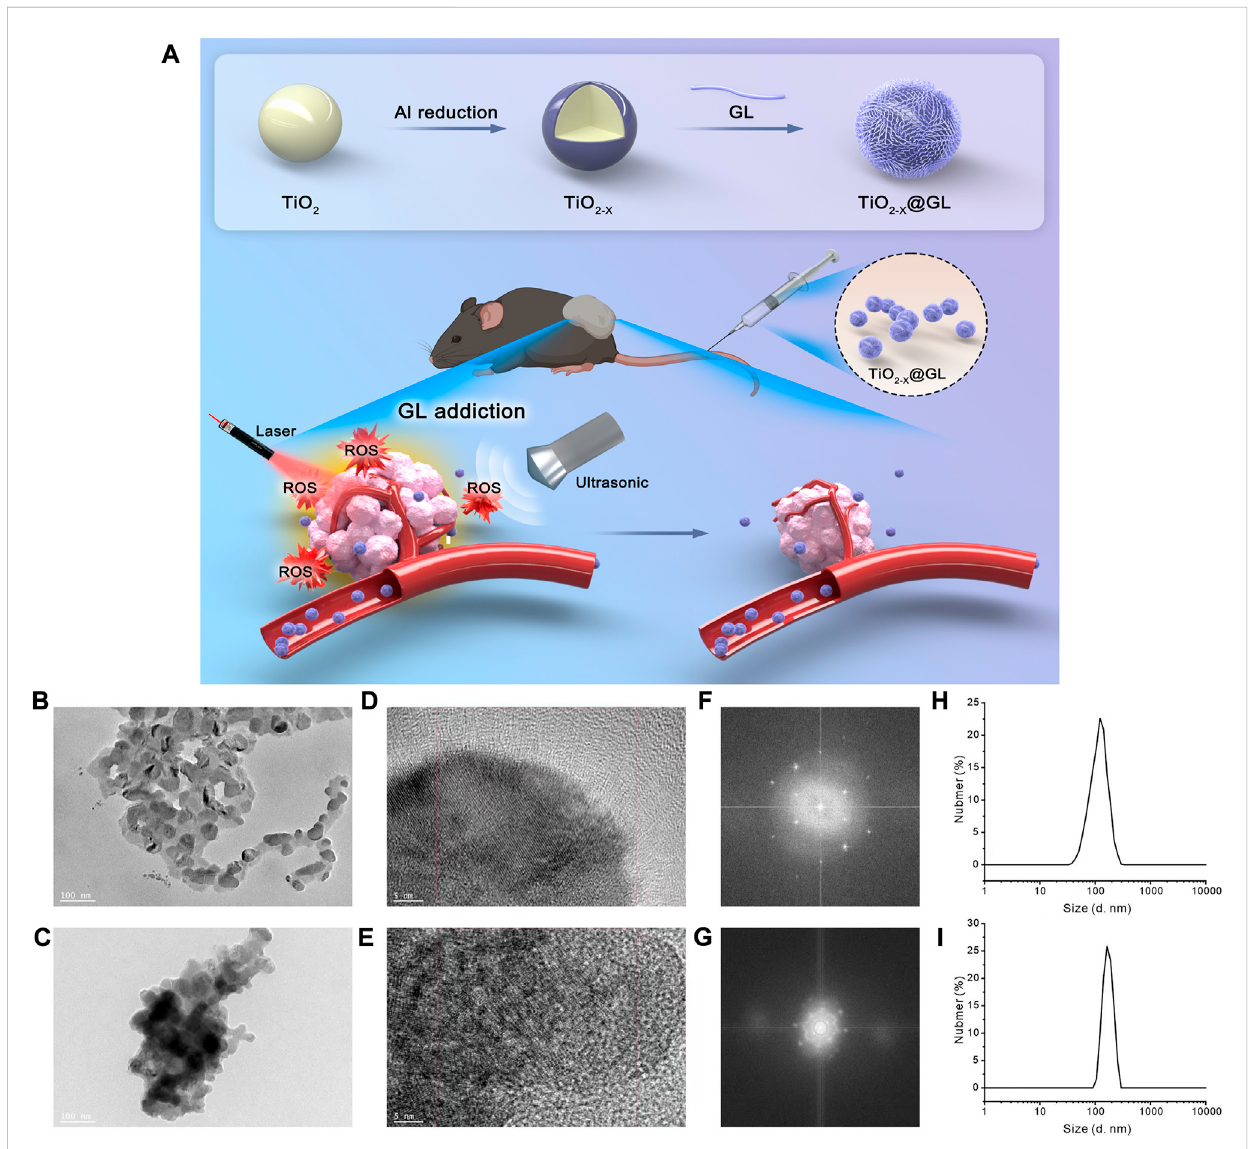
FIGURE 1 Characteristics of TiO 2-x NPs and TiO 2-x @GL NPs (A) Graphical information of the synthesis of TiO 2-x NPs and the synergistic SDT/PTT cancer therapy. (B,C) Low-magni fi cationTEMimagesofTiO 2-x NPs (B) ;andTiO 2-x @GLNPs (C,D,E) High-resolutionTEMimagesofTiO 2-x NPs (D) ;andTiO 2-x @ GL NPs (E, F, G) SAED pattern images of TiO 2 -x NPs (F) ; and TiO 2-x @GL NPs (G, H, I) DLS of TiO 2-x NPs (H) ; and TiO 2-x @GL NPs (I)